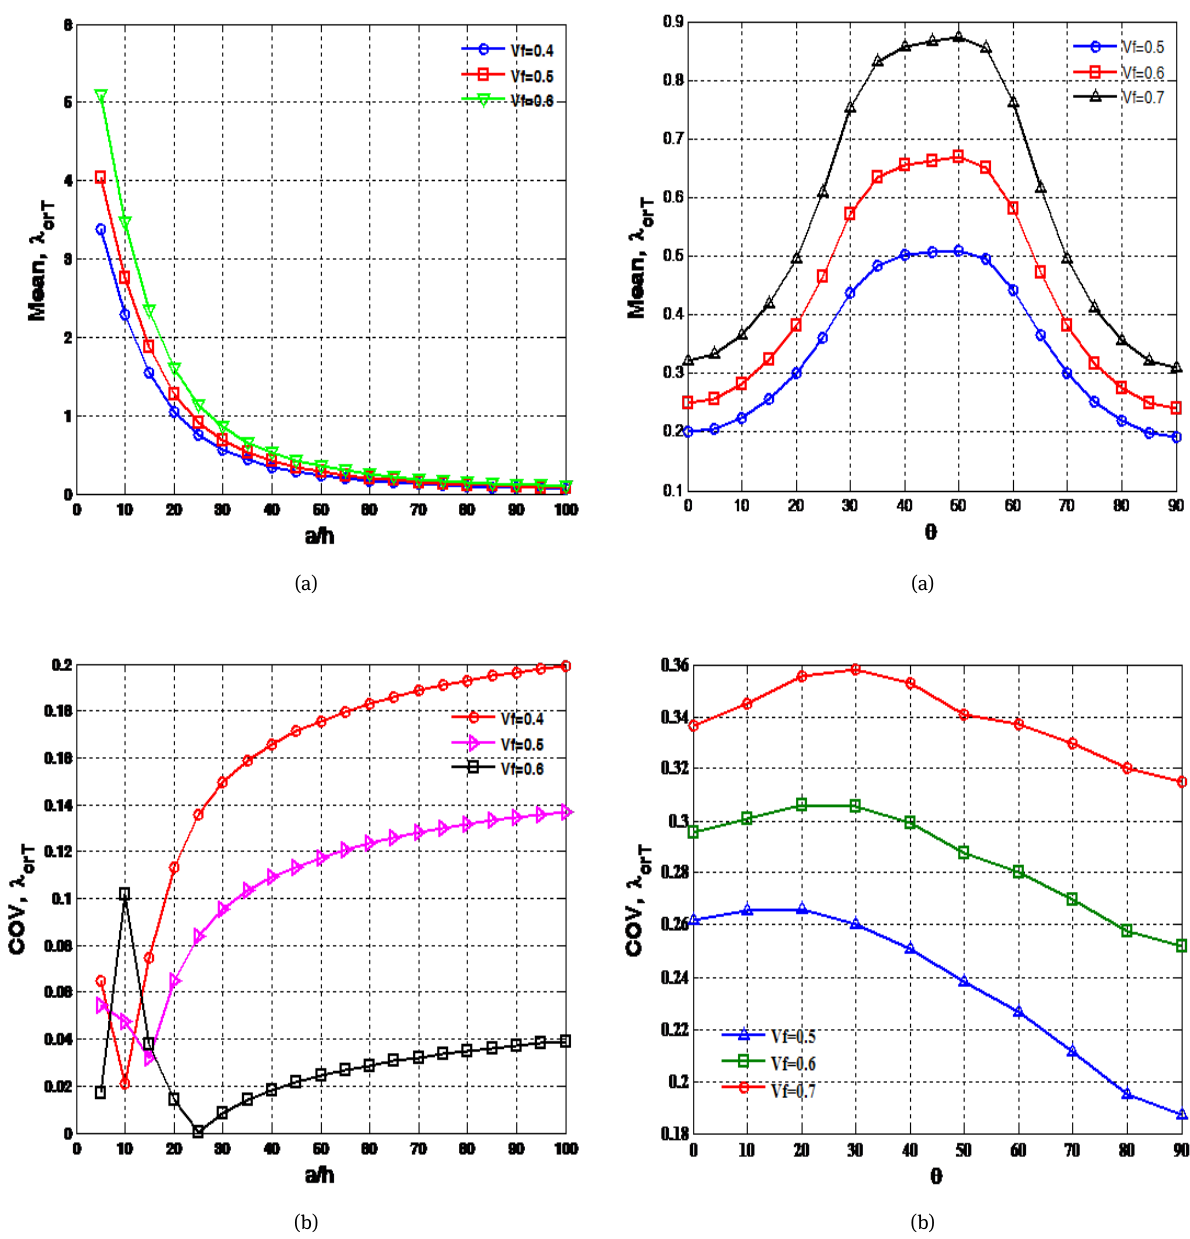
Figure 10: The effect of volume fration of fiber and two layers ply angles [ θ / θ ] with random change in system parameres on the (a) mean and (b) COV of buckling